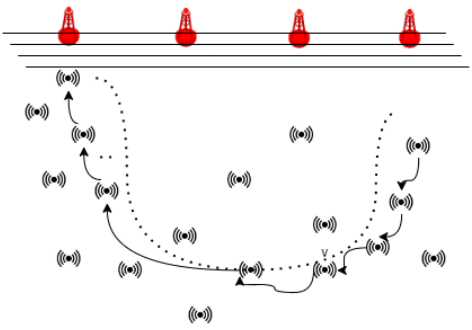
Figure 6. Void avoidance mode in Hydrocast